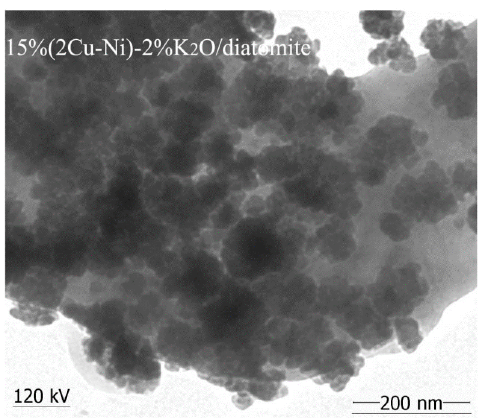
Figure 6. Transmission electron microscopy (EM) image of 15%(2Cu-Ni)-2%K 2 O/diatomite catalyst.